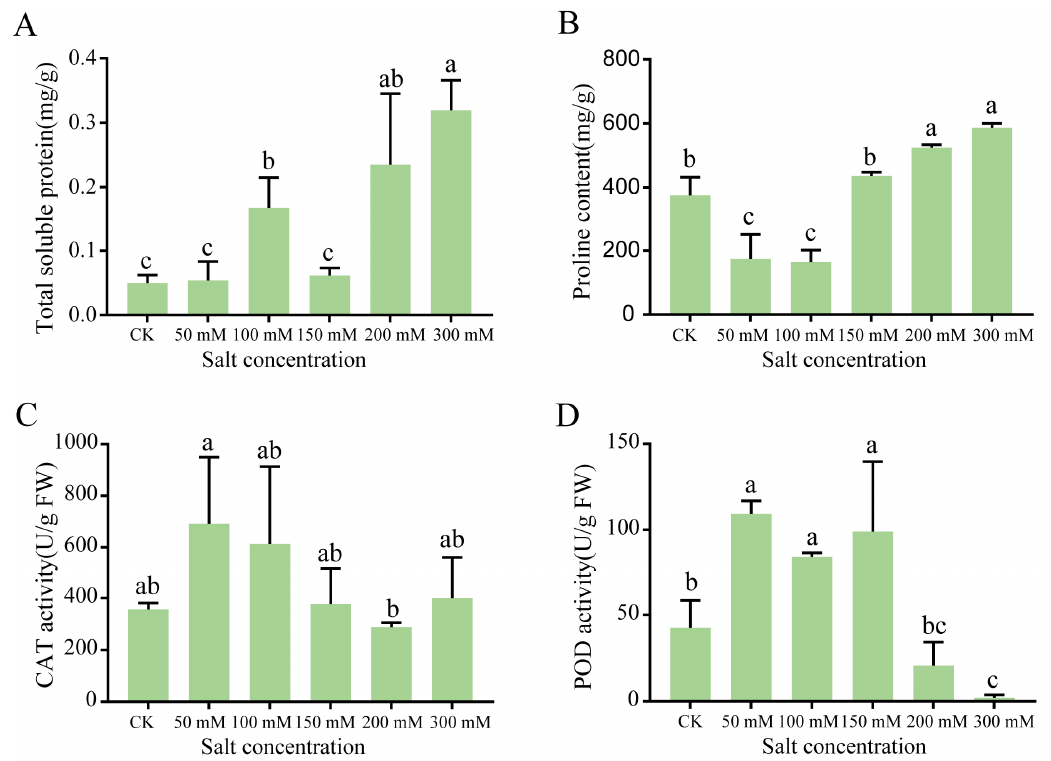
Figure 2. Physiological changes in G. biloba leaves after NaCl treatment. ( A ) Soluble protein content, ( B ) proline content, ( C ) catalase (CAT) activity, and ( D ) peroxidase (POD) activity. Samples were harvested after 14 days. Lower case letters represent significant differences ( p < 0.05). The vertical bars indicate SD ( n = 9).